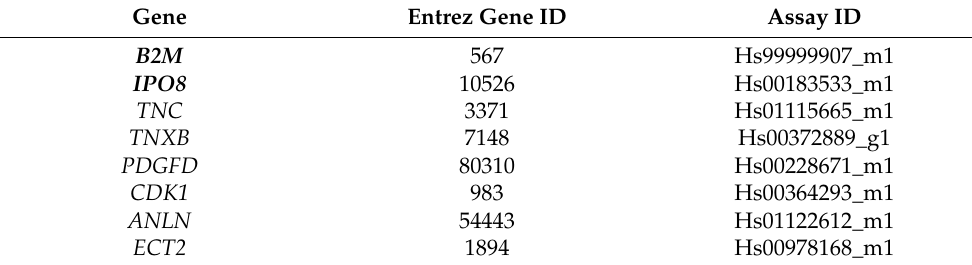
Table 5. Selected